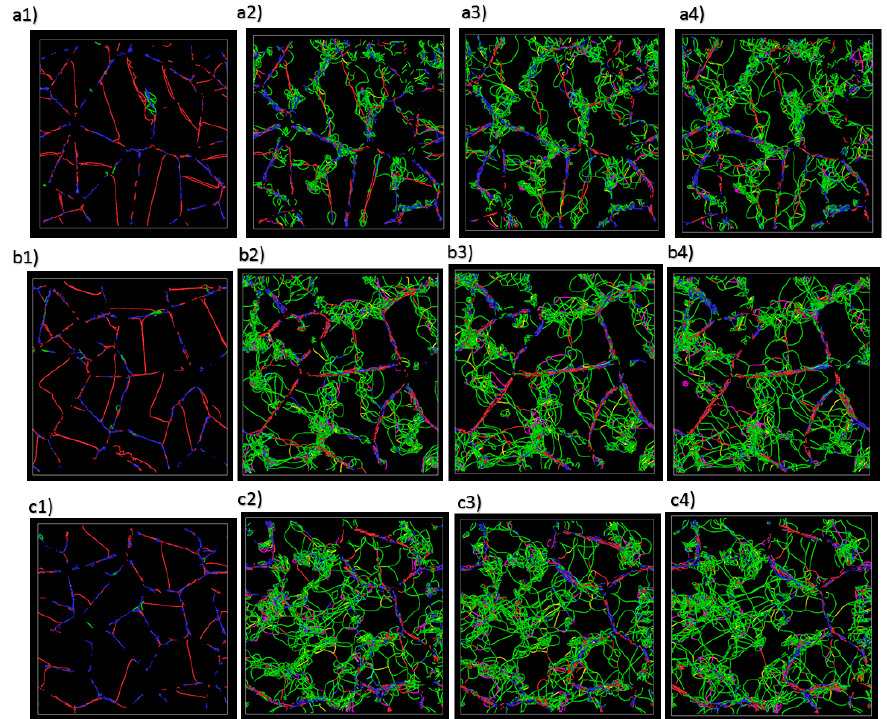
Figure 3. Molecular dynamics simulation snapshots from Dislocation extraction algorithm (DXA) for Cu at ( a1 ) 0 ps, ( a2 ) 20 ps, ( a3 ) 60 ps, ( a4 ) 100 ps, DXA for Ni at ( b1 ) 0 ps, ( b2 ) 20 ps, ( b3 ) 60 ps, ( b4 ) 100 ps, and DXA for equimolar Cu-Ni alloy at ( c1 ) 0 ps, ( c2 ) 20 ps, ( c3 ) 60 ps, ( c4 ) 100 ps.